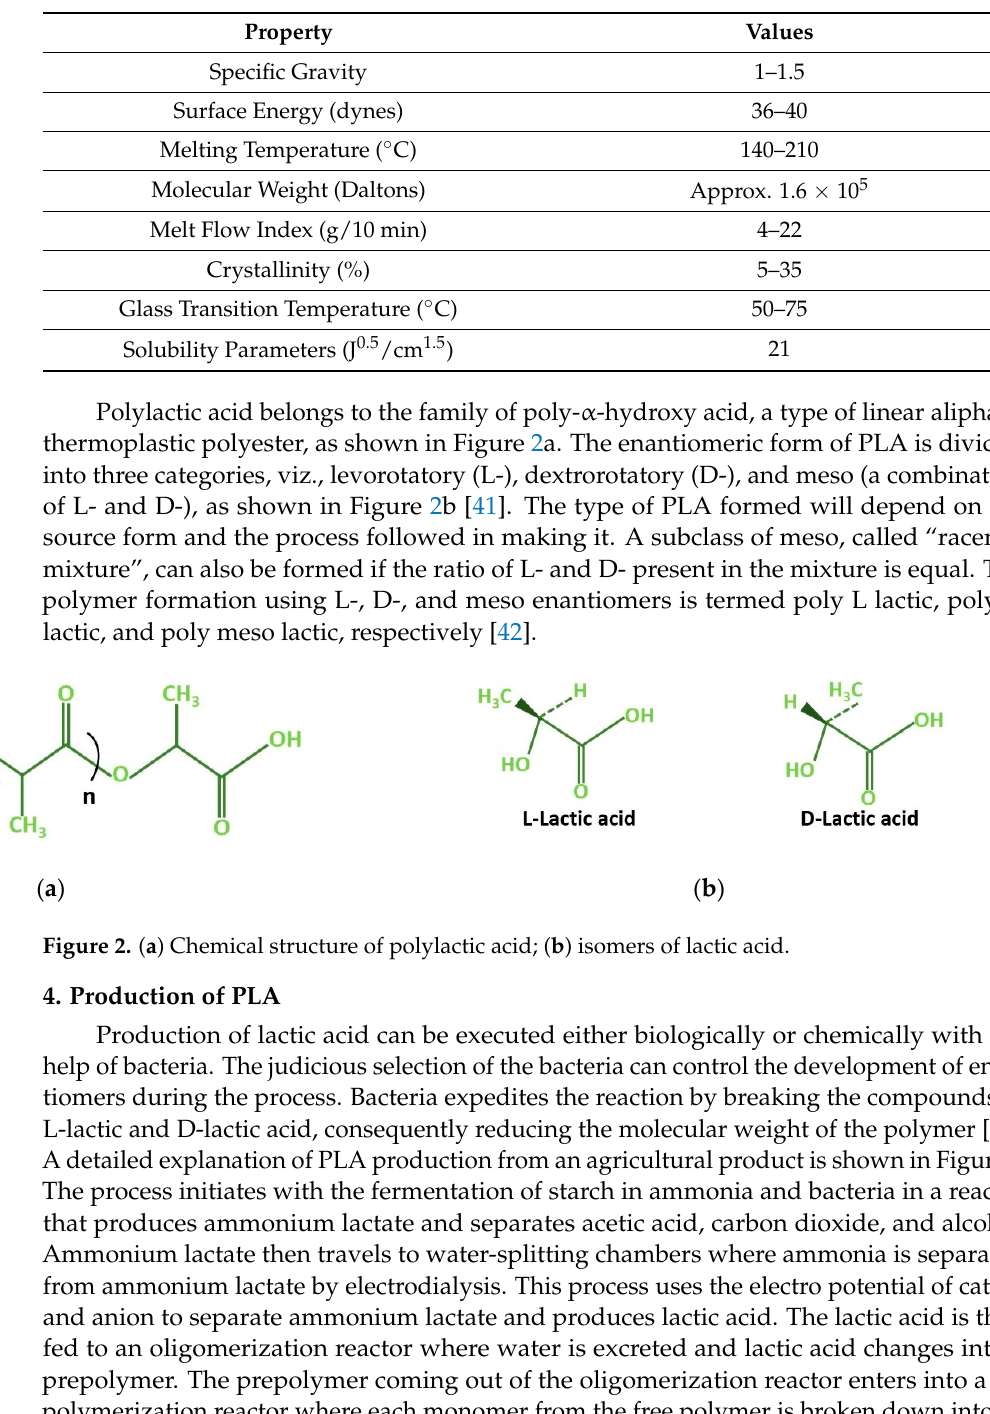
Table 3. Physical properties of polylactic acid [36].